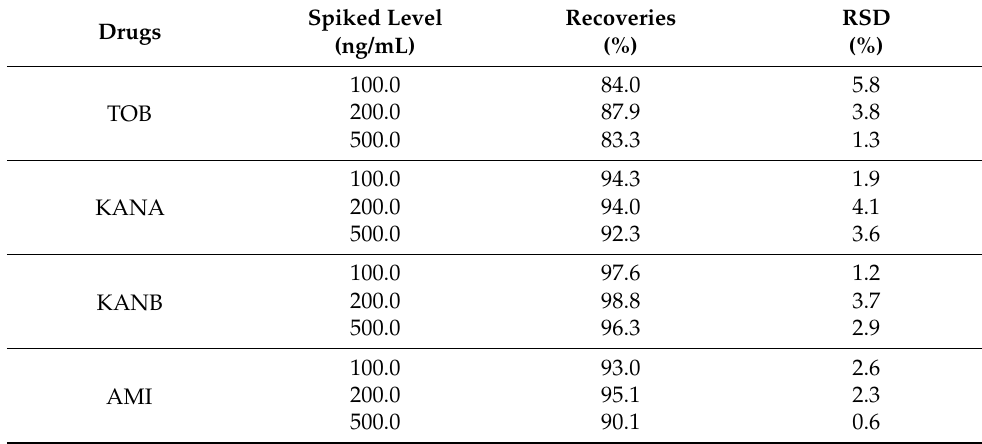
Table 5. Results of standard recovery of 4 kinds of AGs samples ( n =